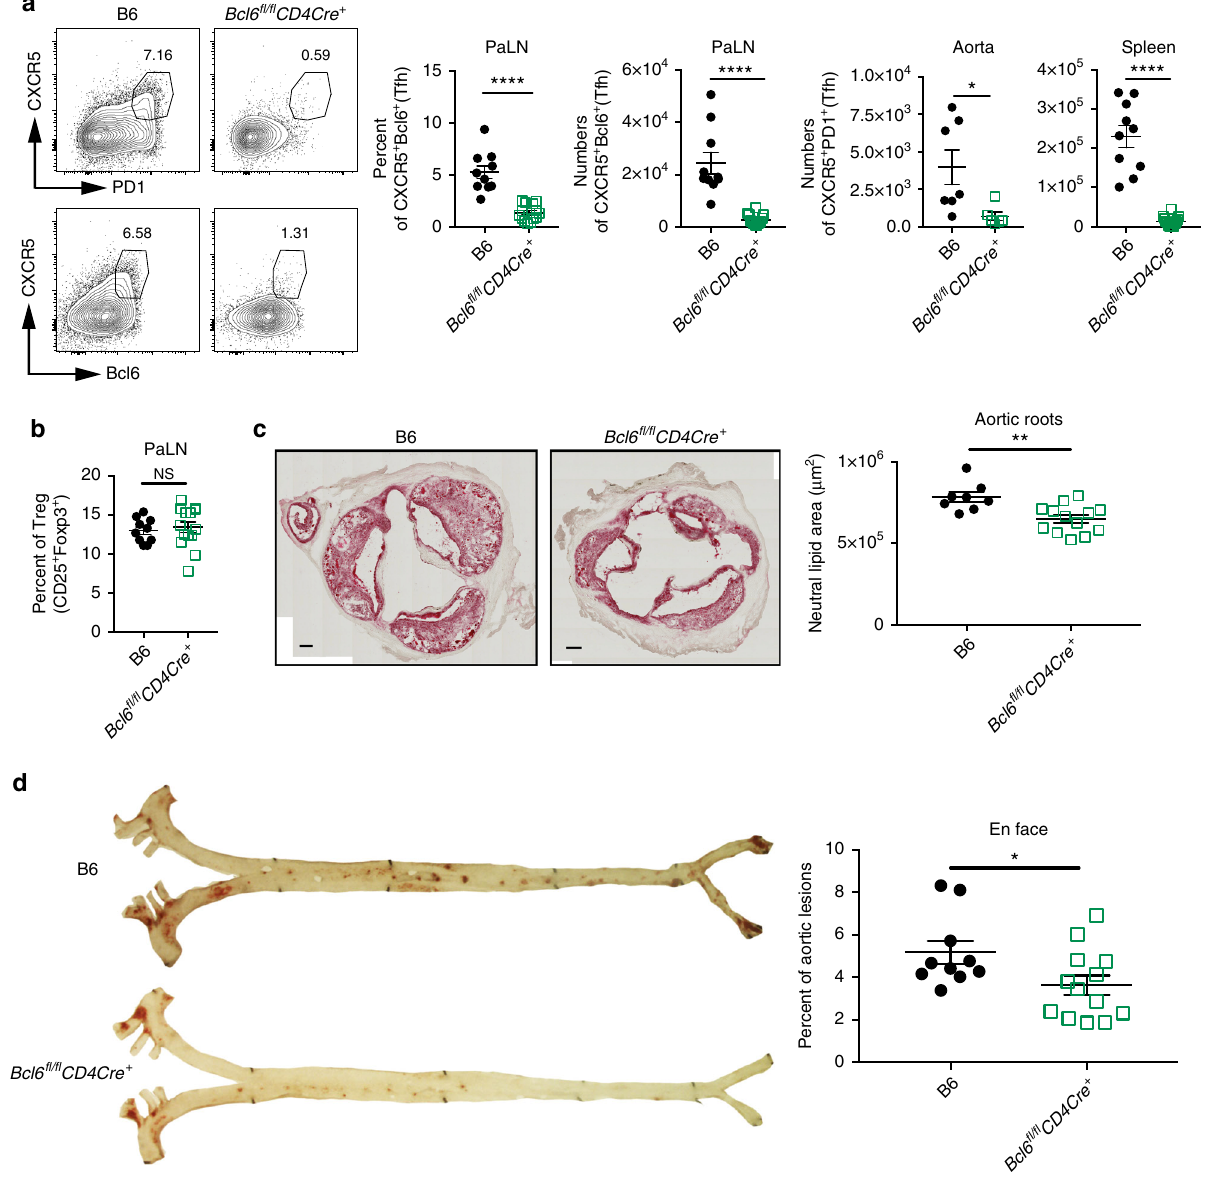
Fig. 4 Tfh cells are pro-atherogenic. a – d B6 or Bcl6 fl / fl CD4-Cre + BM chimera mice on Ldlr − / − background were fed high cholesterol diet for 15 weeks. a – b Flow cytometry plots and graphs showing the percentages and numbers of Tfh cells in PaLN, aorta and spleen ( a ) and percentages of Treg cells ( b ) in the PaLN. c Oil Red O stain of the aortic roots from the above mice. Images are representative sections from each group of mice. The amount of red pixels in each section was determined and the corresponding area was calculated. Each individual dot in the graph is the average of at least 4 sections per aorta per mouse. Scale Bars = 100 µ m. d En face Oil Red O staining in the aorta of the above mice. Graph shows quanti fi cation of the lesion area as a percentage of the total aortic surface area. Results are expressed as mean ± s.e.m. from one experiment ( n = 12 (B6) and n = 14 ( Bcl6 fl / fl CD4Cre + ) ( a – b ), n = 8 (B6) and n = 13 ( Bcl6 fl / fl CD4Cre + ) for PaLN and spleen, n = 7 (B6) and n = 6 ( Bcl6 fl / fl / CD4Cre + ) for aorta ( c ), and n = 10 (B6) and n = 13 ( Bcl6 fl / fl CD4Cre + ) ( d )). Statistical signi fi cant differences were at * P < 0.05, ** P < 0.01, and **** P < 0.0001 (unpaired Student ’ s t -test). NS none signi fi